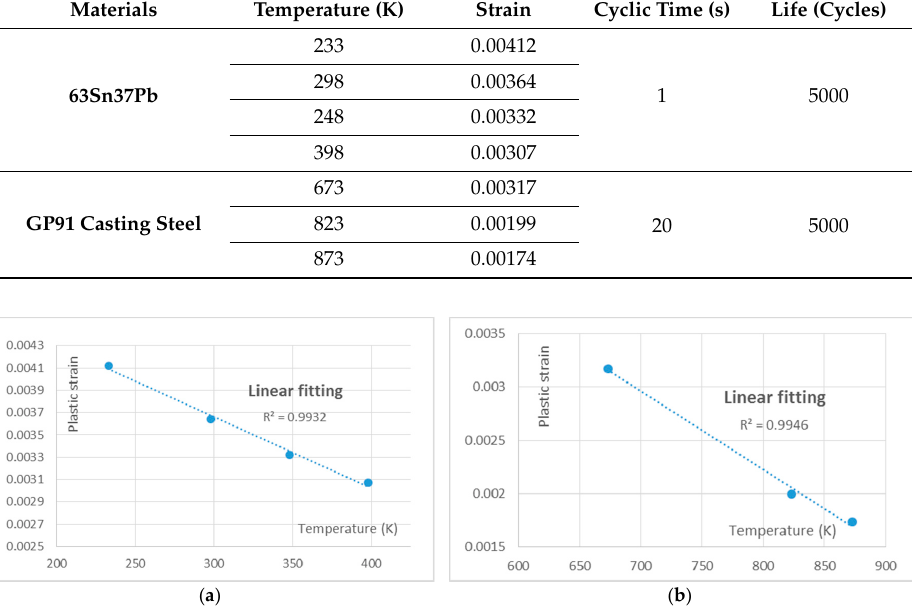
Figure 4. Curve fitting of temperature vs. strain for experimental data: ( a ) 63Sn37Pb; ( b ) GP91 casting steel. Raw data from [21,30] respectively.